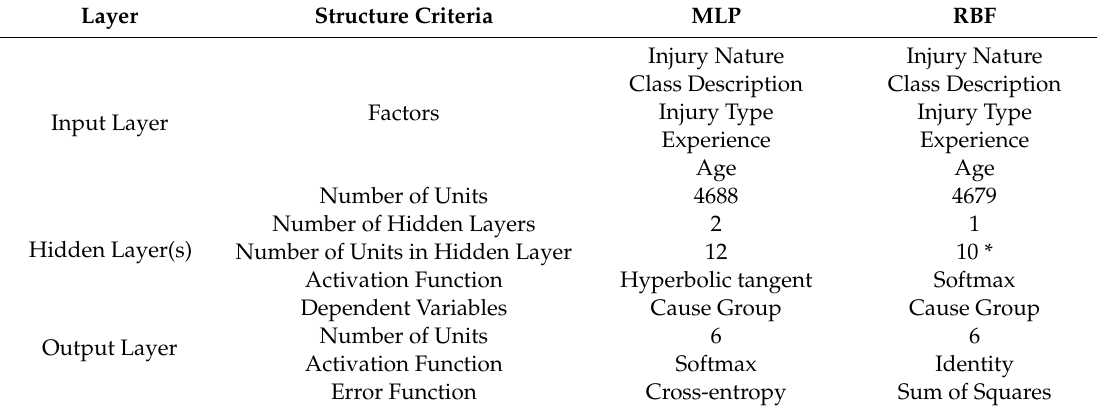
Table 2. MLP vs RBF Network